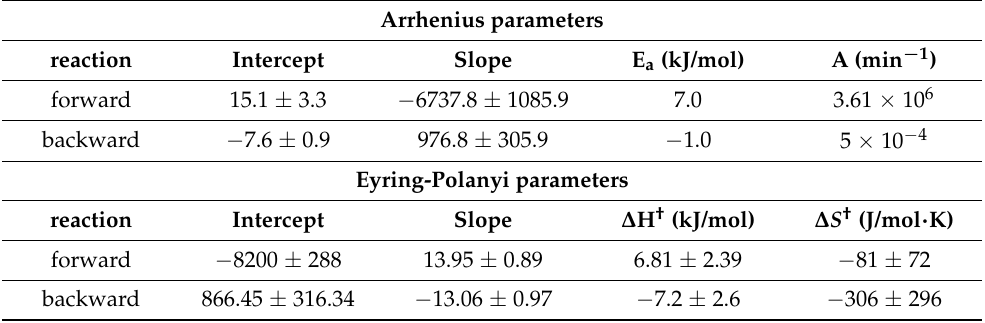
Table 1. The parameters fitted using Arrhenius and Eyring-Polanyi equations. Arrhenius parameters reaction Intercept Slope E a (kJ/mol) A (min − 1 ) forward 15.1 ± 3.3 backward Eyring-Polanyi parameters reaction Intercept